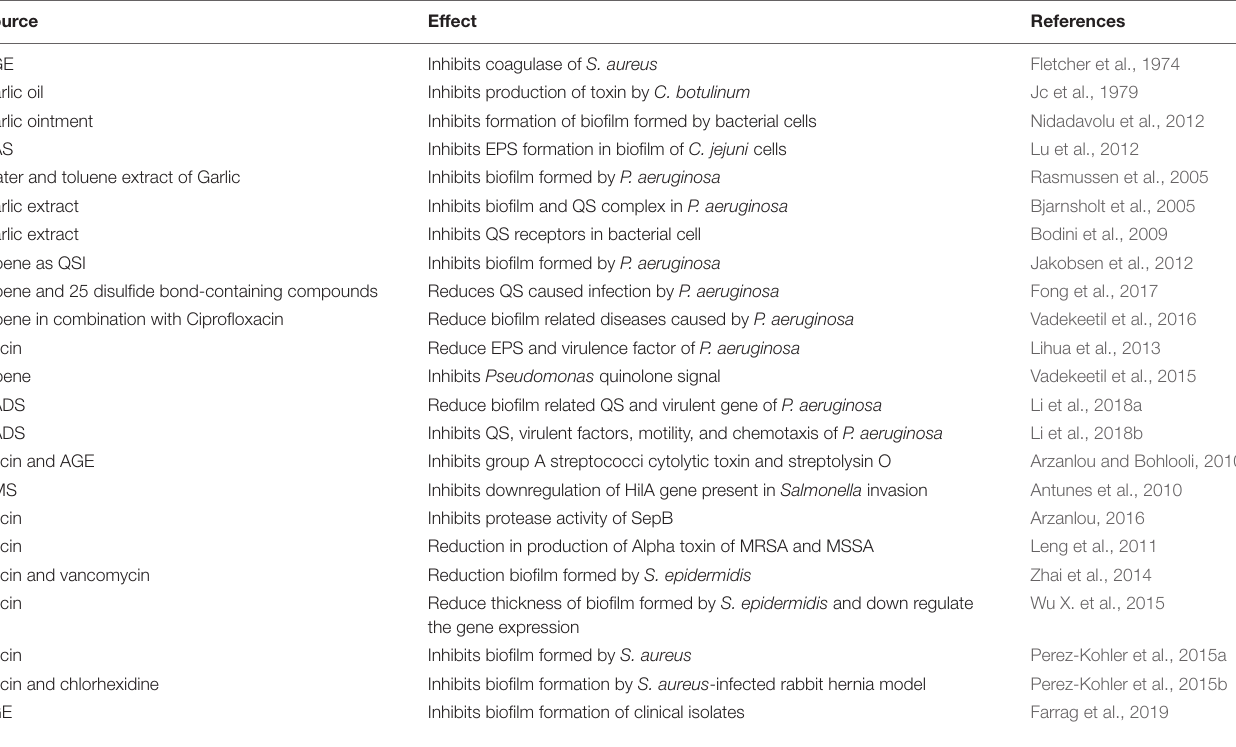
TABLE 3 | Antibiofilm, antitoxin, and anti-QS activity of garlic and its compounds.